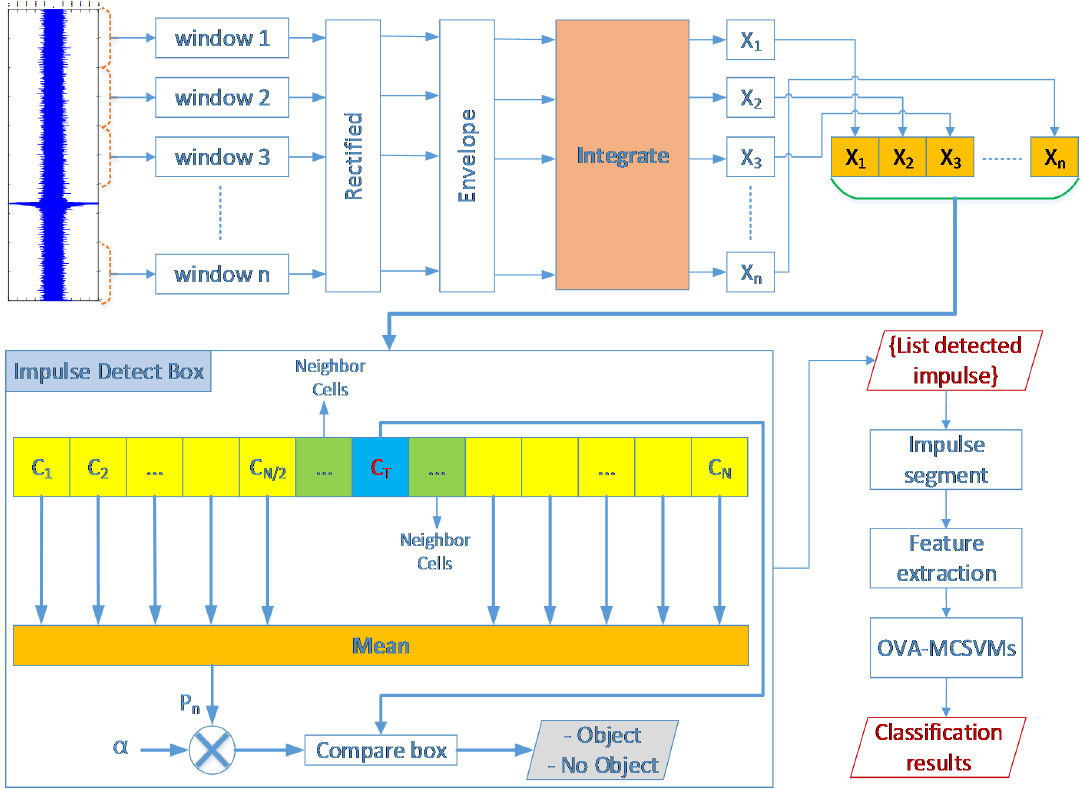
Figure 2. The proposed method of the Enhanced Constant Fault Alarm Rate (ECFAR) algorithm for burst detection.